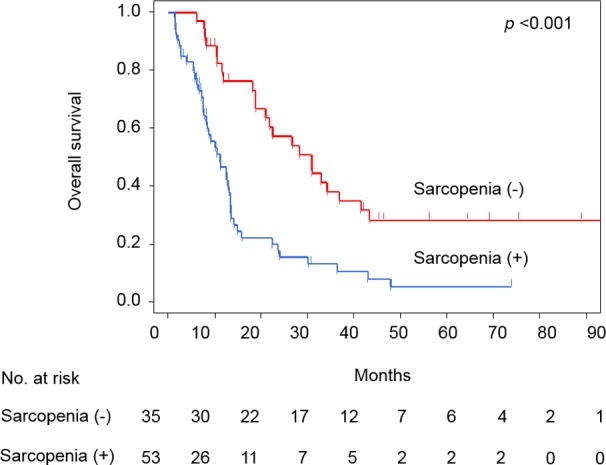
Overall survival of all patients with or without sarcopenia.